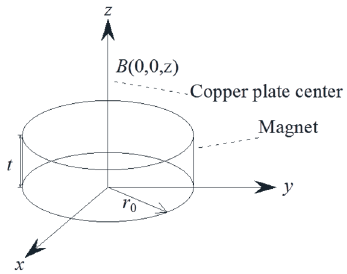
Figure 3. Magnetic flux density along centerline of cylindrical magnet.